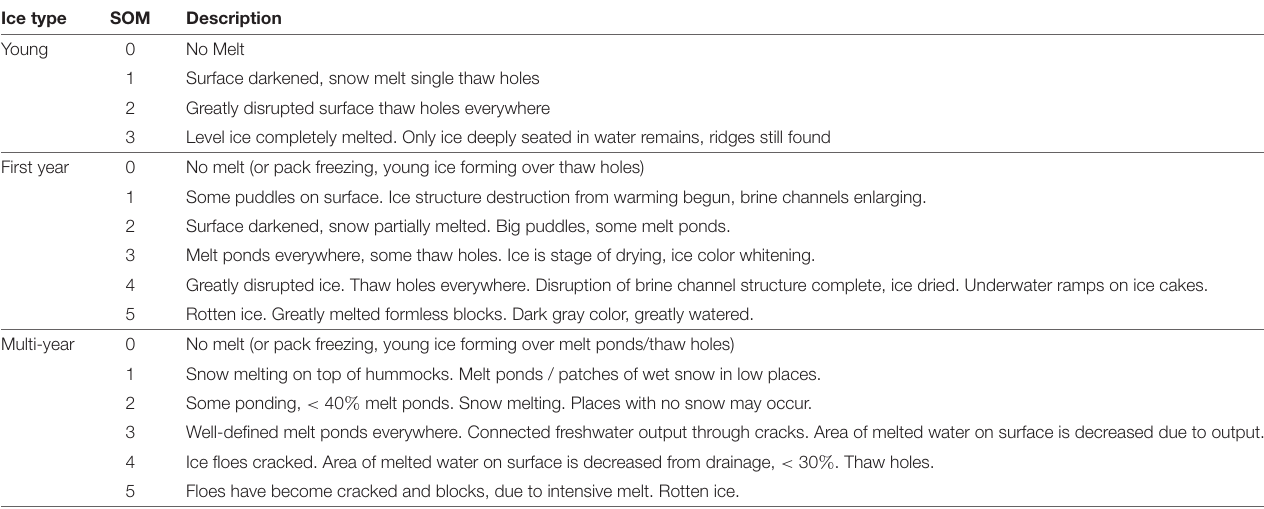
TABLE 2 | Stage of melt (SOM) classification for different ice types, following Russian ice observer convention (pers. comm. Vasily Smolyanitsky, 2003). Ice type SOM